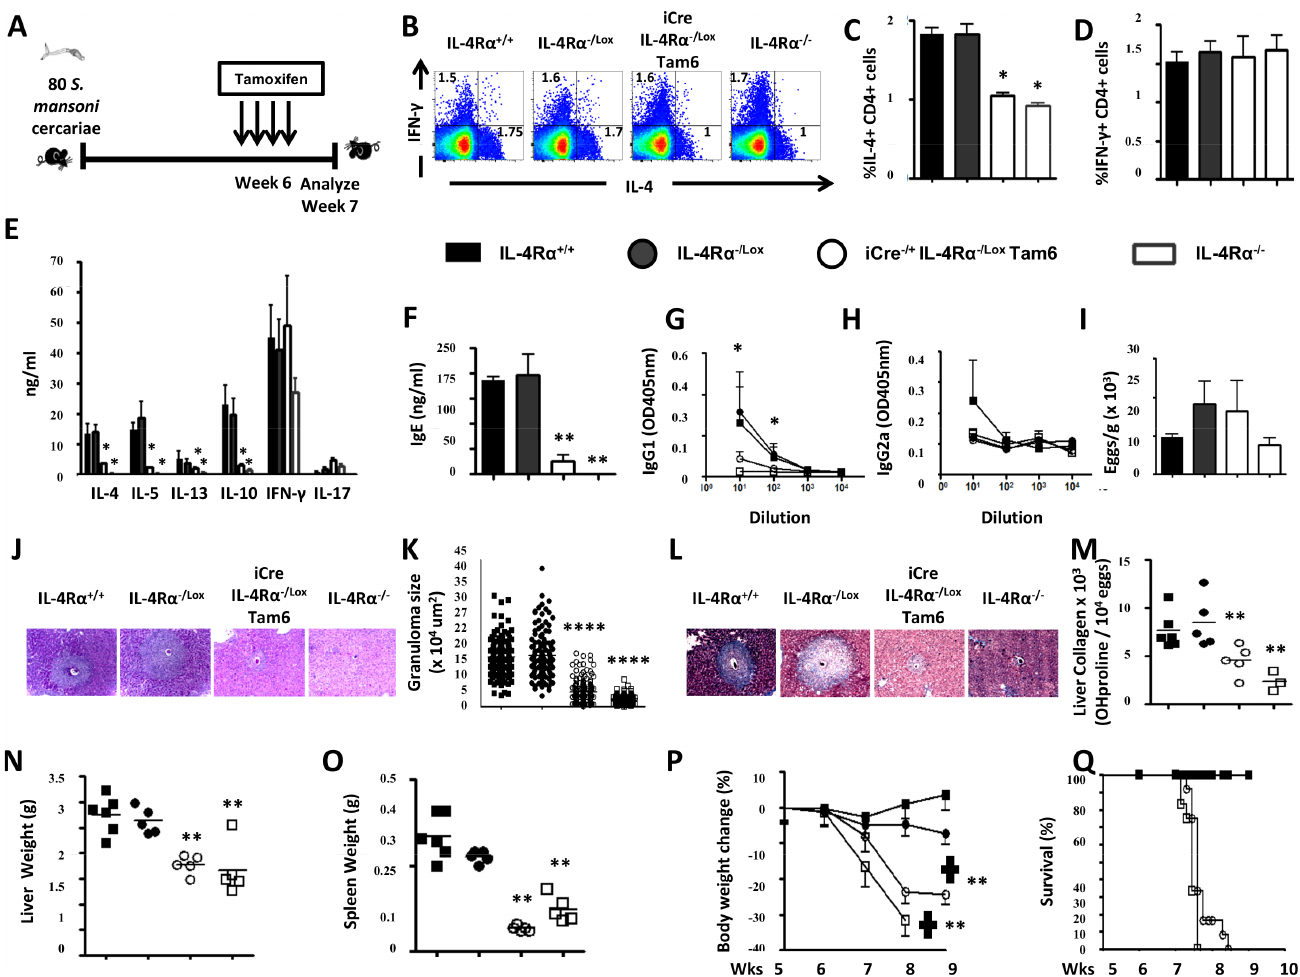
Fig 5. Immunological and histopathological profile of S . mansoni- infected mice after knocking down IL-4R α 6 weeks post-infection. A. Experimental design. B. Representative plot of MLN cytokine-producingCD3 + CD4 + T cells after stimulationwith PMA/Ionomycin/Monensin cocktail. Summaries of IL-4-producing ( C ) and IFN γ -producing ( D ) CD3 + CD4 + T cell frequencies from 2 independentexperiments conducted with 5–10 mice are shown E. Cytokine releasedetected by ELISA in the supernatant of anti-CD3stimulatedMLN cells. F. Total seric IgE in S . mansoni-infected mice. SEA-specificseric IgG1 ( G ) and IgG2a ( H ) isotype antibodies. I. Liver Egg burden. J. Formalin-fixed Hematoxylin/Eosin-stained sections of liver tissue from infected animalsfor morphological analyses(displayedhere at 100X). K. Area sizes of egg-surrounding granuloma are computed. L. Formalin- fixed CAB-stained sectionsof liver tissue from infected animalsfor collagendetection(displayedhere at 100X). M. Hydroxyproline content measured by colorimetry is displayedas a measure of tissue collagencontent. Liver ( N ) and Spleen( O ) weights. P. Body weight changeover time following S . mansoni infection. Q. Survival curve following S . mansoni infection. Each experiment was conductedat least twice with 5–10 mice per group. Data are expressedas mean ± SD; NS = p > 0.05; * = p < 0.05; ** = p < 0.01; *** =, p < 0.001; **** = p < 0.0001.